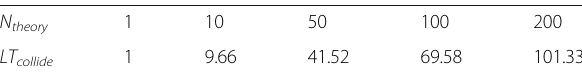
Table 1 The theoretical relationship between collision and tag